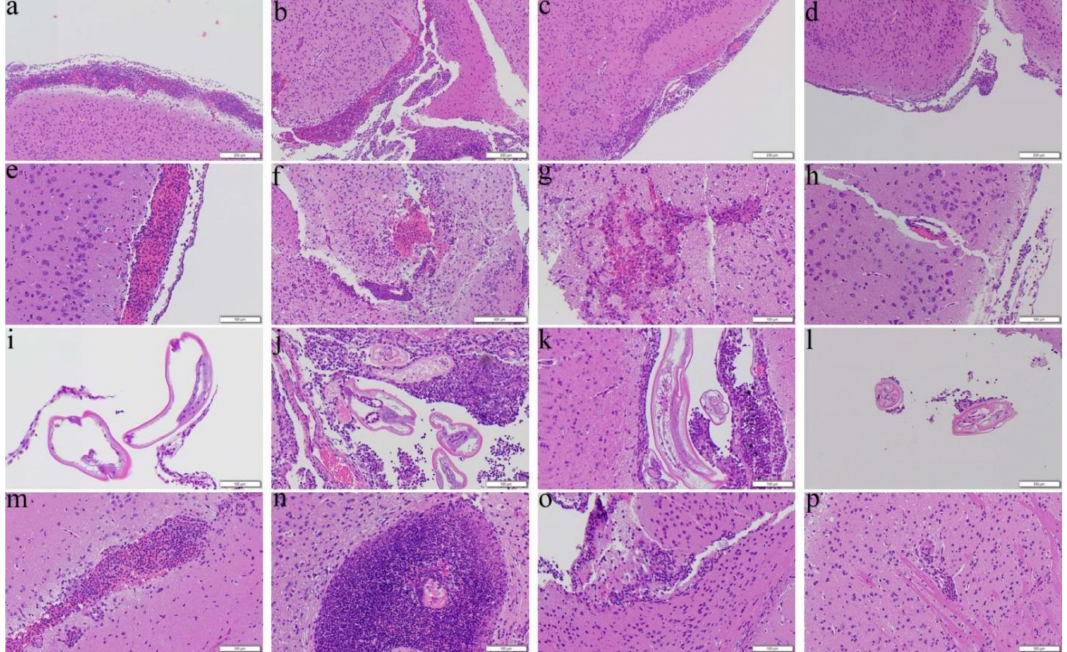
Figure 7. Representative photomicrographs showing meningitis, presence of worms, hemorrhage, and encephalitis in the cerebral parenchyma of the C57BL/6 mice infected with Angiostrongylus cantonensis treated from day 14 for 7 days. ( a , e , i , m ) Untreated mice. ( b , f , j , n ) Mice treated with albendazole alone. ( c , g , k , o ) Mice treated with dexamethasone alone. ( d , h , l , p ) Co-therapy of albendazole and